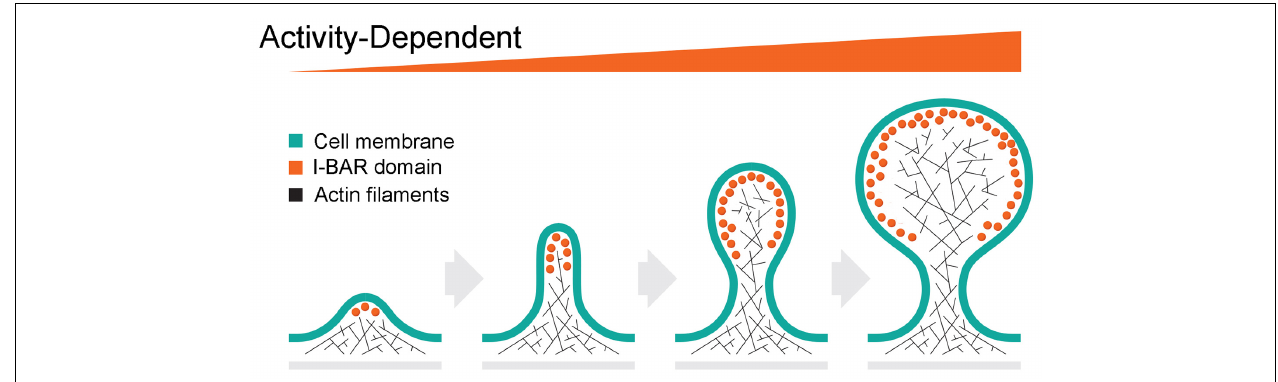
FIGURE 2 | Hypothetical role of I-BAR proteins on activity-dependent spine initiation, elongation and maturation. The formation of the dendritic spine begins with the initiation of filopodia. Activity-dependent recruitment of I-BAR proteins stimulates actin cytoskeleton growth resulting in further elongation of the filopodia. Further increase of I-BAR membrane density induces branching of the actin filaments due to Arp 2/3 complex activity, creates the spine head, and enhances spine plasticity.